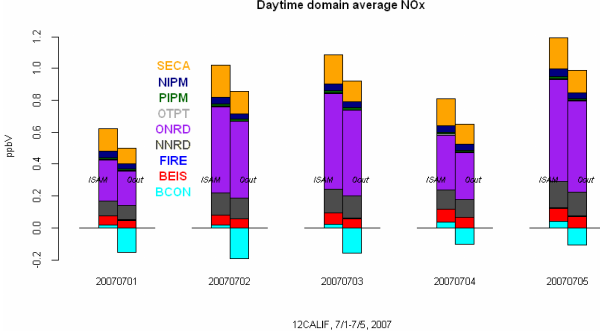
Figure 7. Daytime domain-averaged ambient NO x (NO + NO 2 ) , 1– 5 July 2007 (28–30 June excluded due to large initial conditions in- fluence). As in Fig. 4, for each day the left column designates ISAM total, and right one the zero-out. The colors represent sector sources: marine (MARINE, orange), non-electricity generation units (Non- EGU, deep blue), electricity generation units (EGU, green), other point sources (MEX, light grey), on-road mobile (ONRD, purple), non-road mobile (NNRD, yellow), wildfires (FIRE, blue), biogenic (BIOG, red), and boundary conditions (BCON,